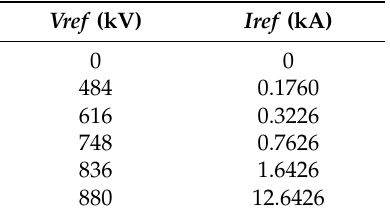
Table 1. Nonlinear v-i characteristic of the arresters [27].